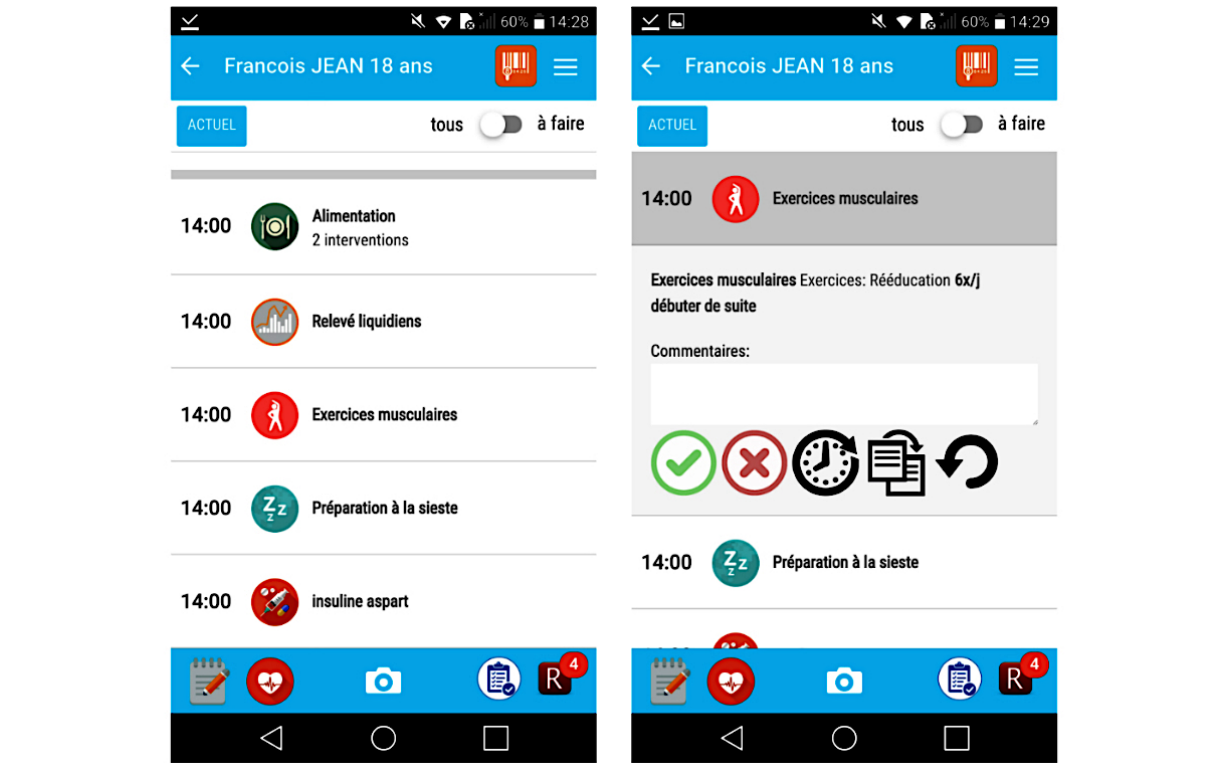
Figure 3. Problem related to use of back button. Whereas an opened intervention is closed by clicking on it again, many users used the back button and returned on the previous screen (patient selection